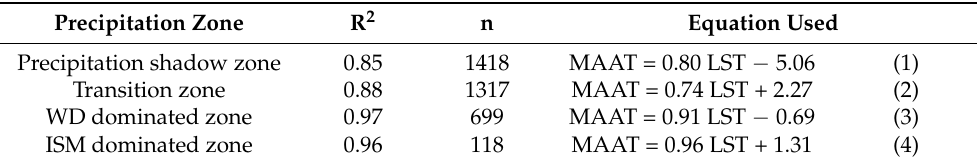
Table 1. Details of relationship used to convert mean annual land surface temperature (LST) to mean annual air temperature (MAAT) for different precipitation zones (R 2 = coefficient of regression between LST and MAAT; n = number of observations) (modified after Singh et al. [71]). Precipitation Zone R 2 n Equation Used Precipitation shadow zone 0.85 1418 MAAT = 0.80 LST − 5.06 (1) Transition zone 0.88 1317 WD dominated